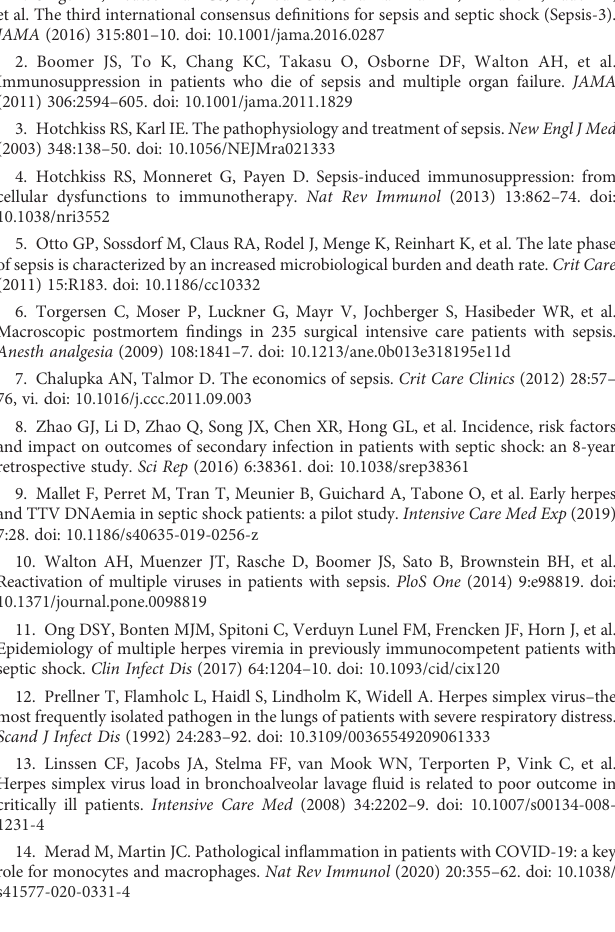
monocytes in blood (n=6). Data are mean ± s.e.m., *P < 0.05, unpaired, 2- tailed Student ’ s t test using Welch ’ s correction for unequal variances was used. SUPPLEMENTARY FIGURE 5 WT mice exhibit the same phenotype than Il-3 -/- mice 7 days after a light CLP. Sub-lethal sepsis was induced in WT and Il-3 -/- mice using the CLP model. Mice weresacri fi ced7dayslater. (A – D) AbsolutenumberofpDCs (A) ,neutrophils (B) , B cells (C) and CD4 + T cells (D) in the lungs, spleen, liver and BM of CLP WT and Il-3 -/- mice (n=6-11). (E – G) Levels of TNF a (E) , IL-10 (F) and IL-1 b (G) in the supernatant of pulmonary cells from CLP WT and Il-3 -/- mice stimulated ex vivo for 3 days with PBS, LPS or CpG (n=6). Data are mean ± s.e.m., *P < 0.05, unpaired, 2-tailed Student ’ s t test using Welch ’ s correction for unequal variances was used. SUPPLEMENTARY FIGURE 6 Phenotype of CpG-activated pDCs upon IL-3 ex vivo stimulation. (A) Levels of plasma IFN l in septic patients with high or low plasma IL-3 levels (n=32). (B) Gating strategy of pDCs in humans. (C) Representative histogram of MFI for CD80, CD40, HLADR and CD86 expressed at the surface of circulating pDCs 24hafterCpGstimulationinthepresenceor theabsenceofIL-3.Dataaremean ± s.e.m., *P < 0.05, unpaired, 2-tailed Student ’ s t test using Welch ’ s correction for unequal variances was used. SUPPLEMENTARY FIGURE 7 Interleukin-3 enhances pDC-mediated CD4 + T cell activation. Representative histogram and cumulative mean fl uorescence intensity (MFI) of CD69, CD71 and CD25 expressed at the surface of allogenic CD4 + and CD8 + T cells primed with CpG-or CpG/IL-3-pre-treated pDCs (n=6-8). Data aremean ± s.e.m., *P< 0.05, paired 2-tailed Student ’ s t test was